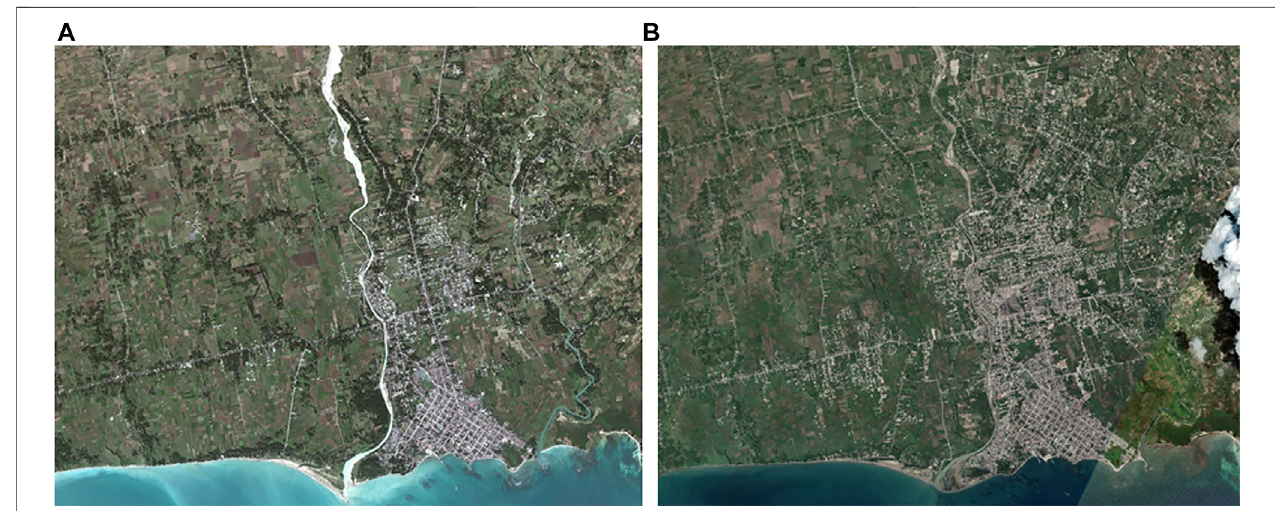
FIGURE 1 | Satellite Imagery of Les Cayes in the south-east of Haiti (A) in 2010 and (B) in 2021, showing the change in population density following the 2010 earthquake and before the 2021 earthquake.